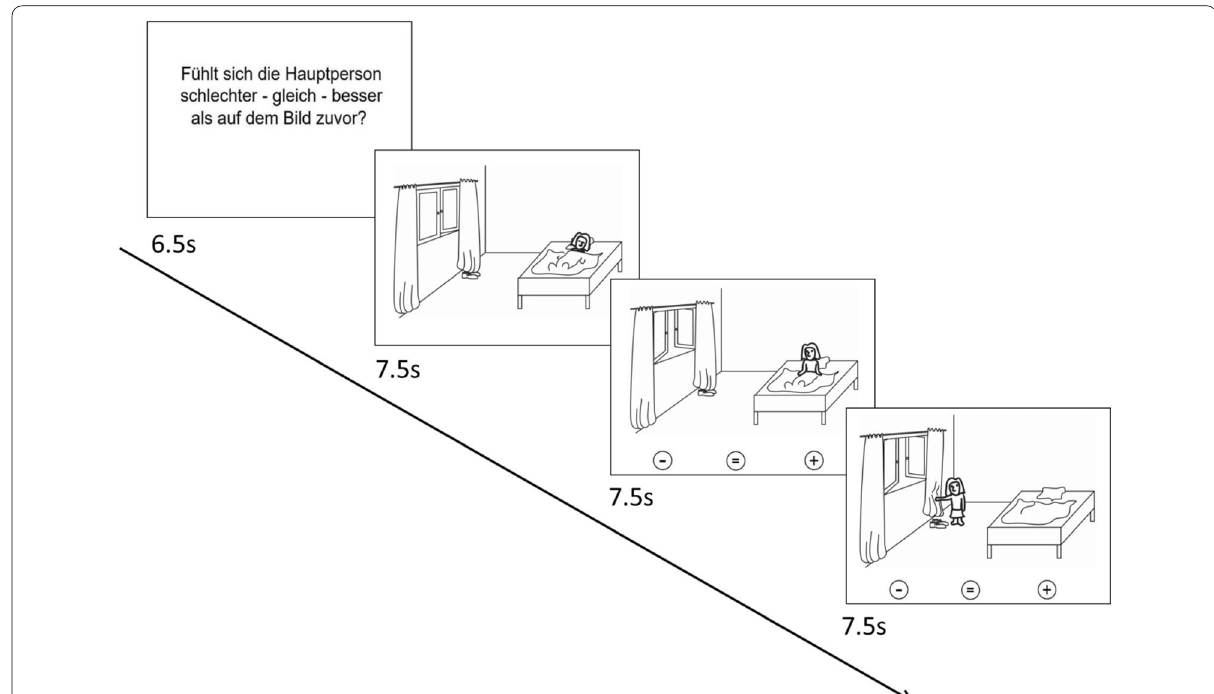
Fig. 4 Graphical depiction of the ToM task. Each trial consisted of an introduction describing the respective task and a cartoon story consisting of three consecutive pictures. This figure illustrates the ToM condition. First an introduction text is shown “Does the person feel worse—equal—better as on the picture before”, which means that the subjects had to judge how the affective state is changed in pictures 2 and 3 compared to the previous picture. In the control condition, the subject has to judge whether the number of living beings is changed